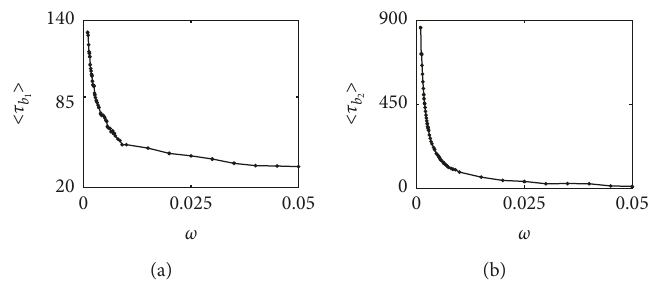
Figure 8: Average bifurcation delay as a function of forcing frequency bifurcation τ b 2 . Other parameter values are fixed same as in Figure (cid:26) (cid:25)